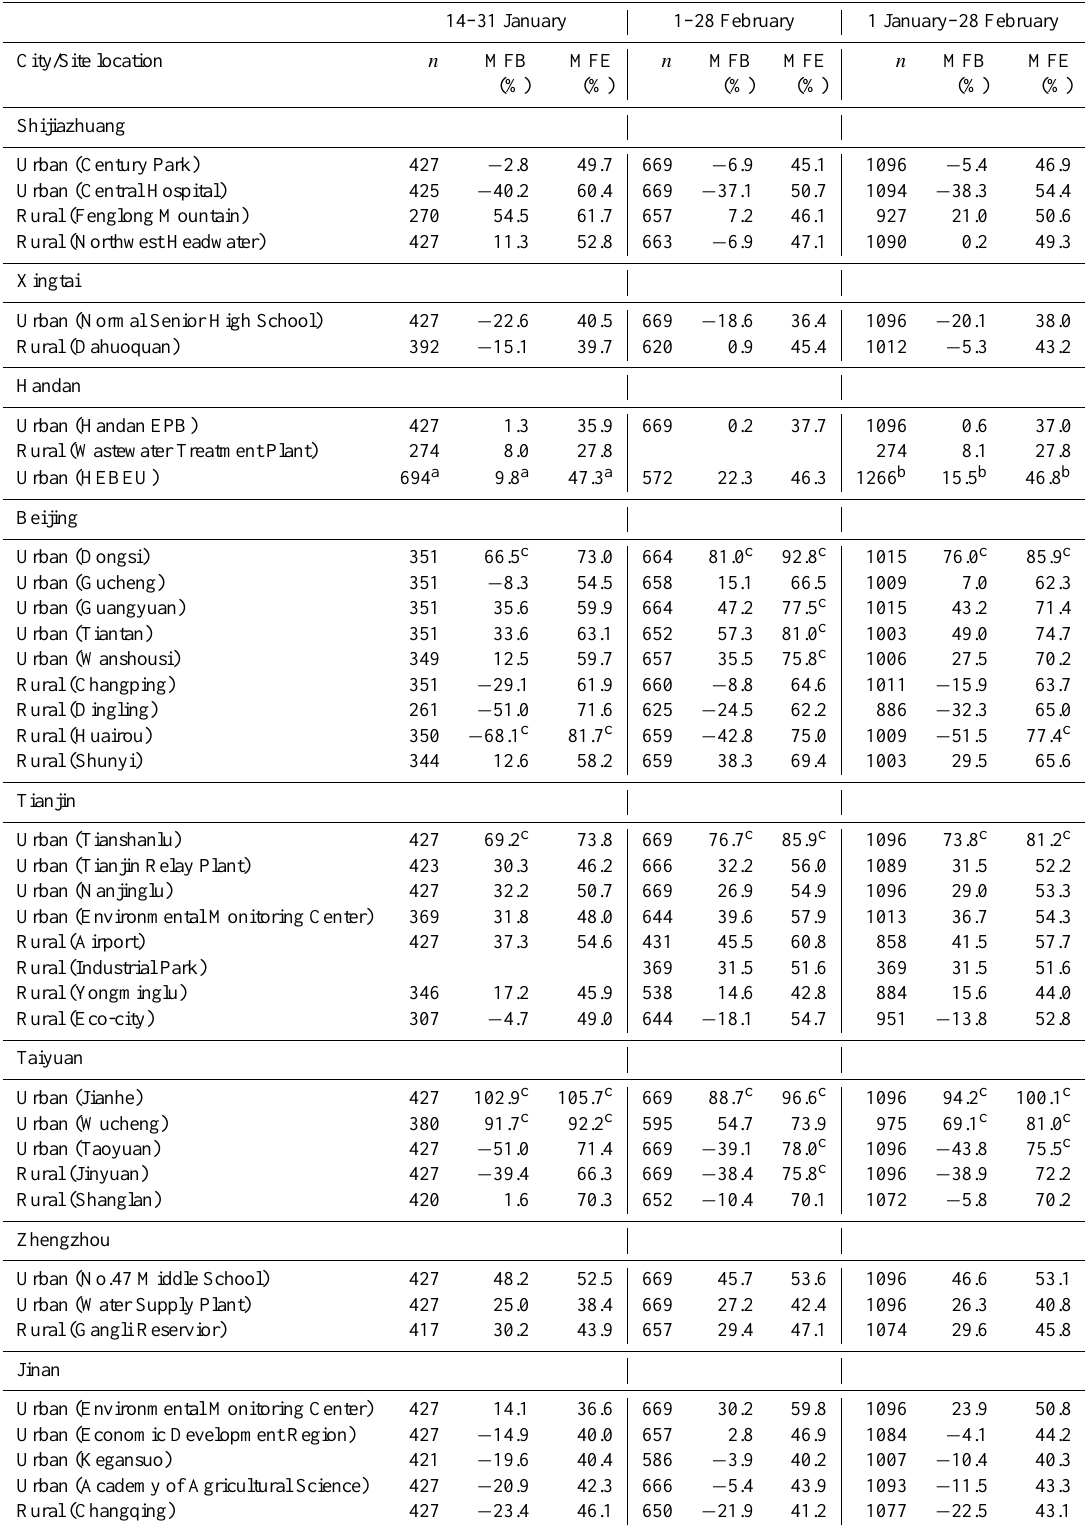
Table 4. MFBs and MFEs for hourly PM 2 . 5 concentrations simulated at the 12km grid resolution in the representative